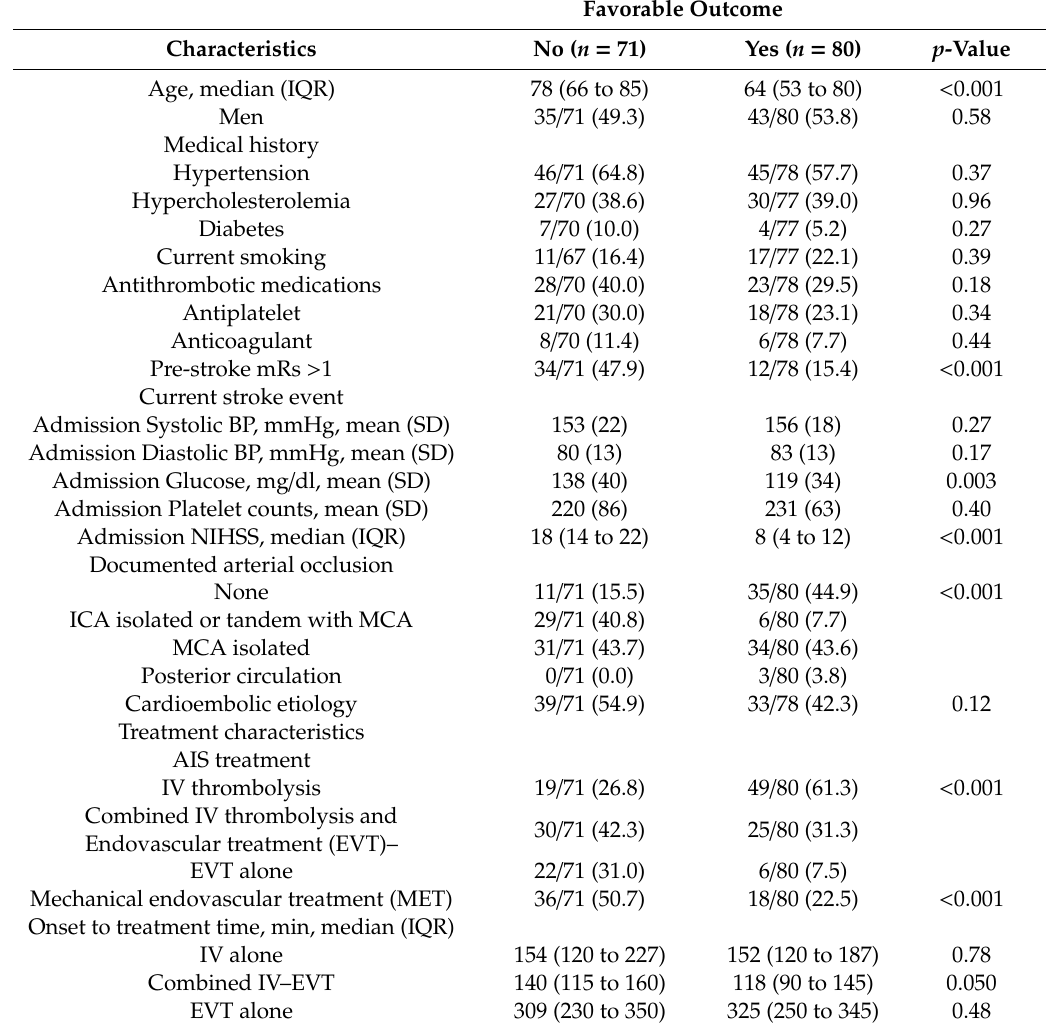
Table 1. Patients’ and treatment characteristics according to a favorable